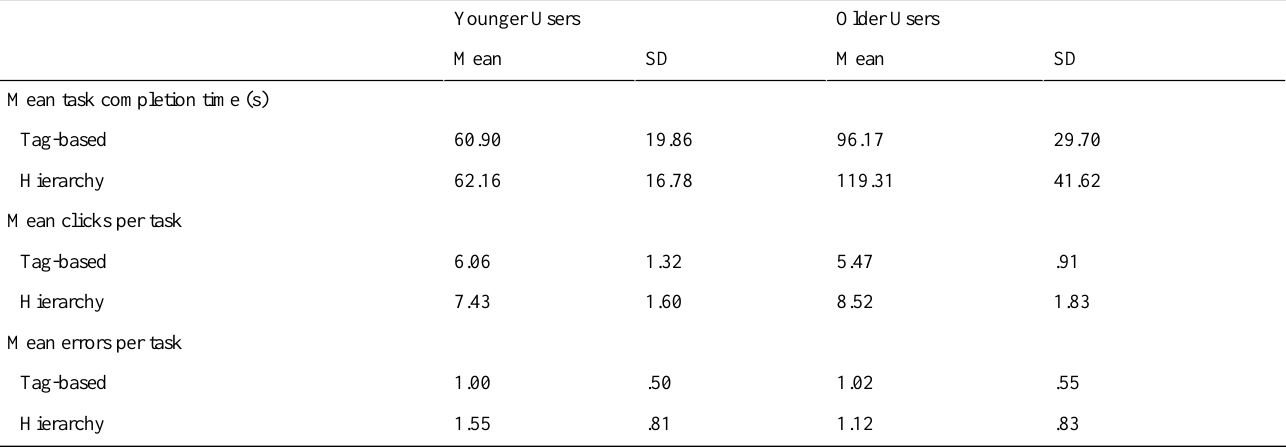
Table 2. Measures of performance as a function of condition and age